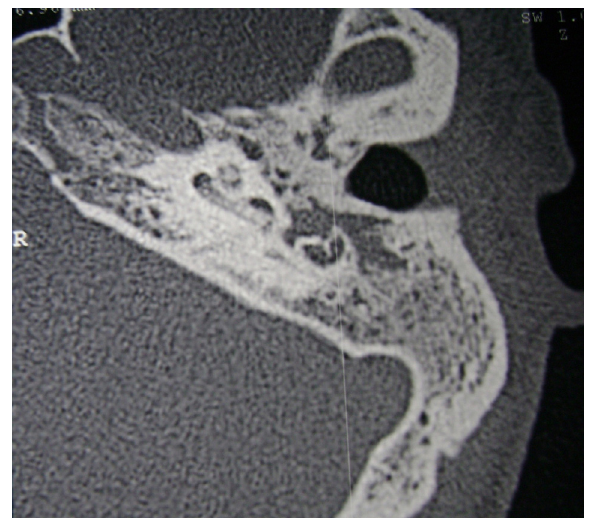
NMR FIESTA sequence, coronal view. The arrow shows hypointense signal in the cochlea and vestibular projec- tion. This is the same patient shown in Fig. 3.